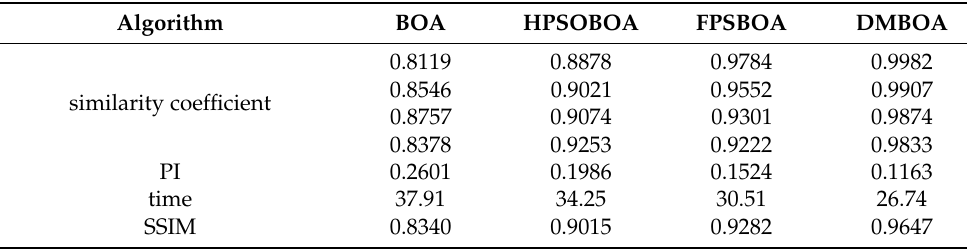
Figure 6. Effect drawing of image signal separation. ( a ) The image of source signals; ( b ) The image of observed signals; ( c ) The image of BOA separated signals; ( d ) The image of HPSOBOA separated signals; ( e ) The image of FPSBOA separated signals; ( f ) The image of DMBOA separated signals. Table 5. Data of image signal separation performance evaluation index.